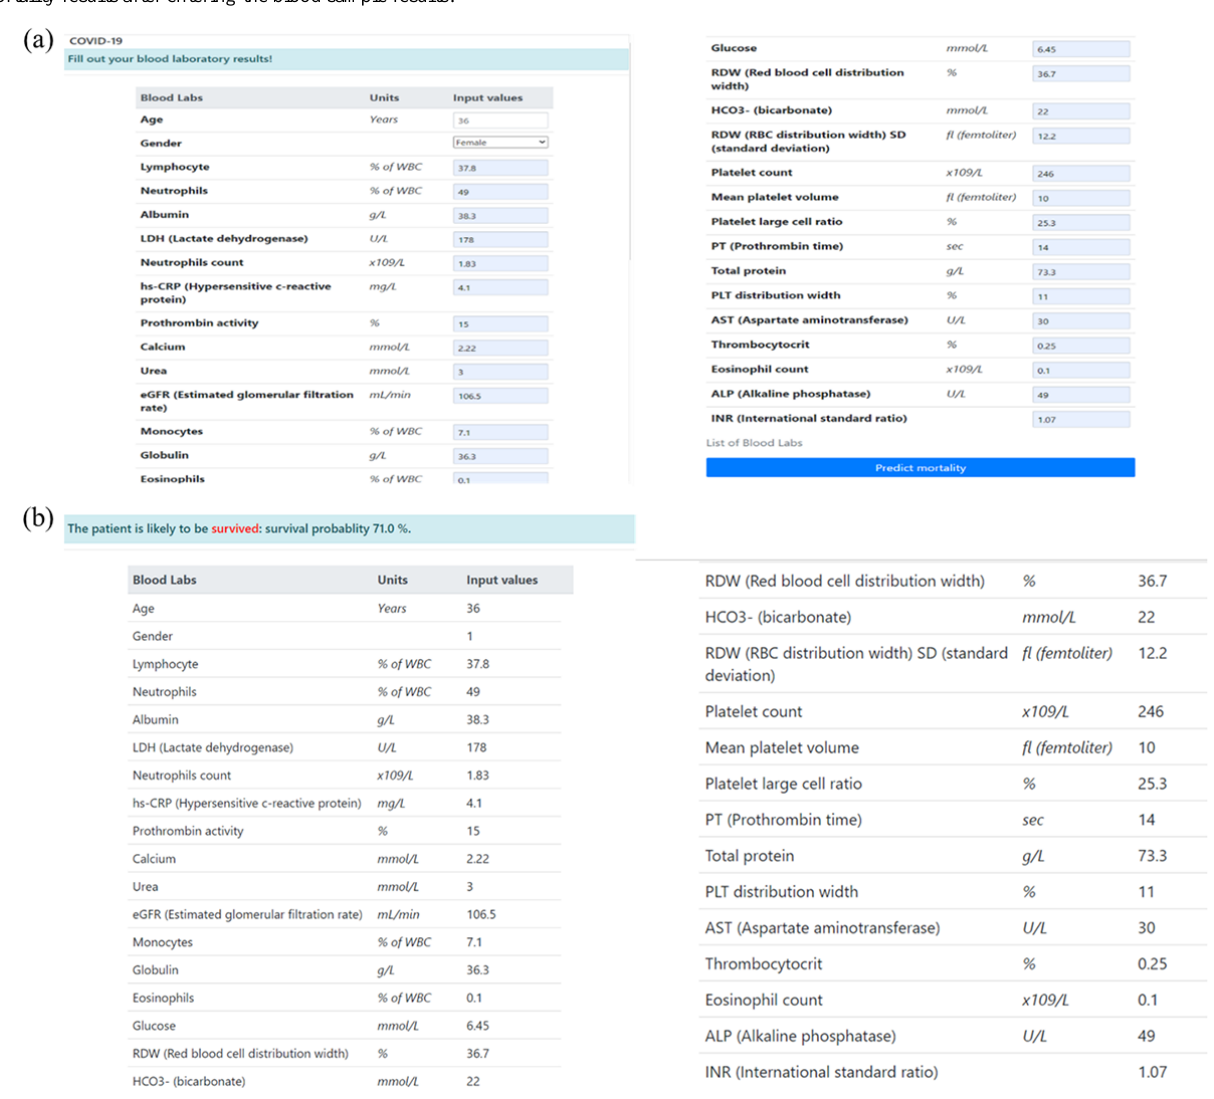
Figure 4. Deployed web application, BeatCOVID19 [25]: (a) input windows where a user inputs his or her blood sample results and (b) the predicted mortality results after entering the blood sample